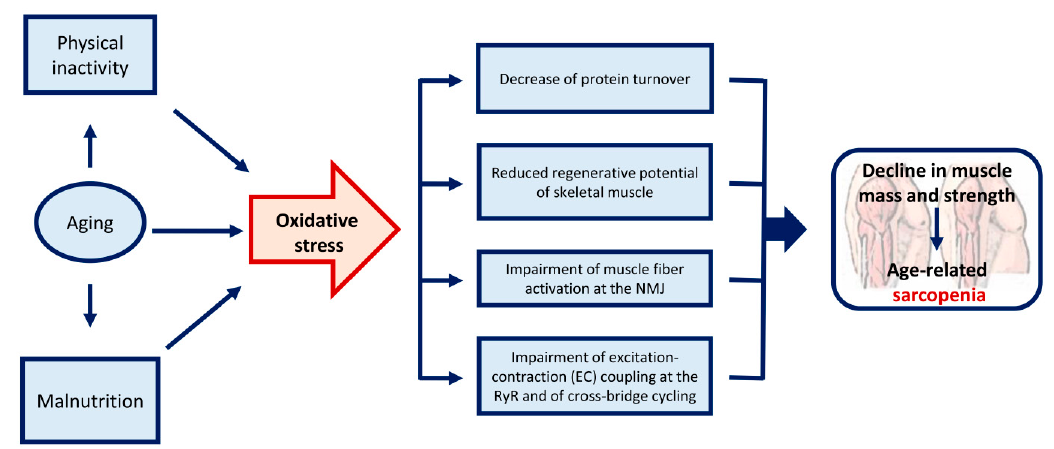
Figure 1. Aging, physical inactivity, and malnutrition lead to oxidative stress, contributing to sarcopenia.